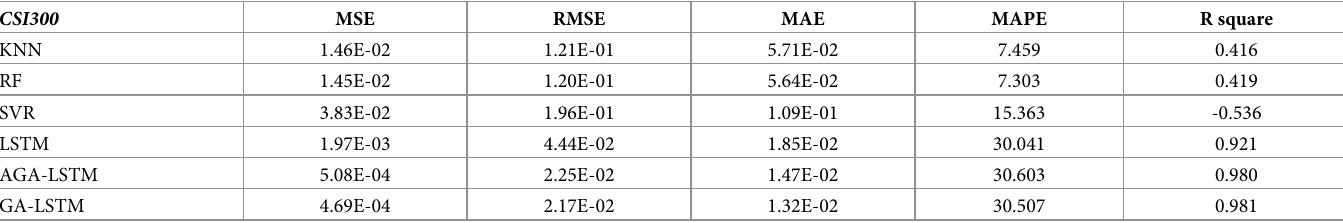
because the fitness difference of each individual was not obvious, an adaptive algorithm based on individual fitness ranking was proposed to improve the speed of finding the optimal solu- tion. In addition, the convergence efficiency of AGA was higher than that of GA. To obtain better accuracy, there are many directions to explore in the future. For example, using more features of big data, such as the emotional characteristics of investors in the stock market, may improve prediction accuracy. With the further application of deep learning, high-dimensional data mining and time-series prediction, considering the influence of multi-state correlation will also become the next research direction.